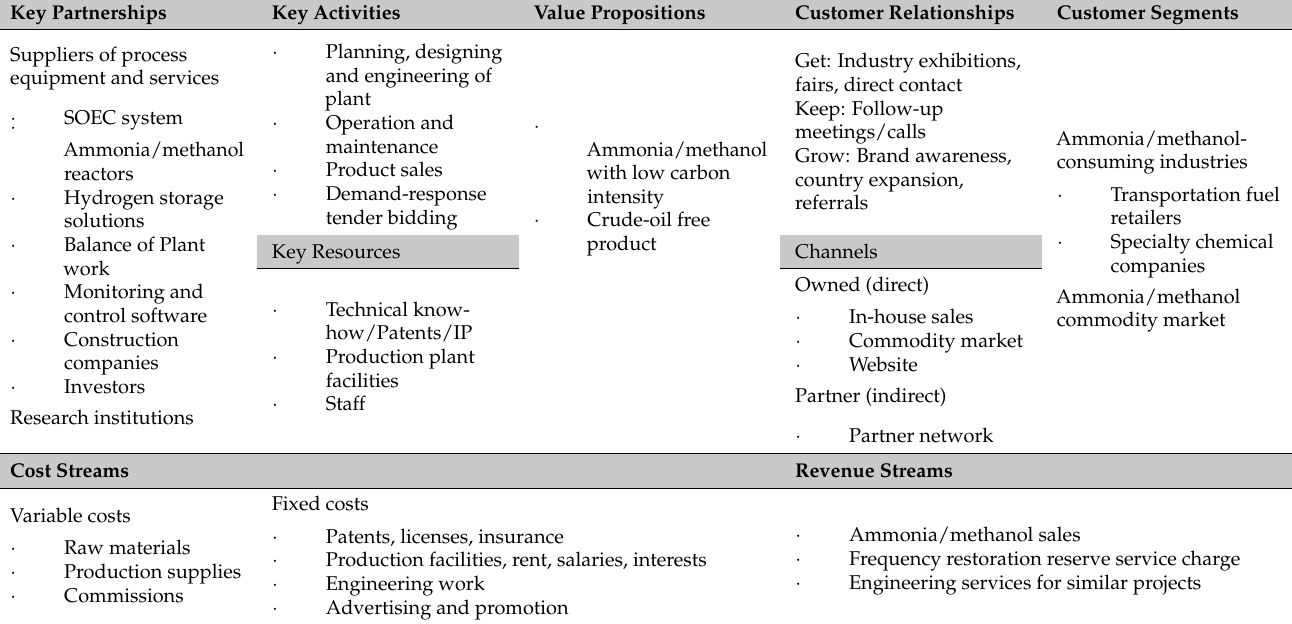
Table 3. Canvas of the engineering firm and operator business